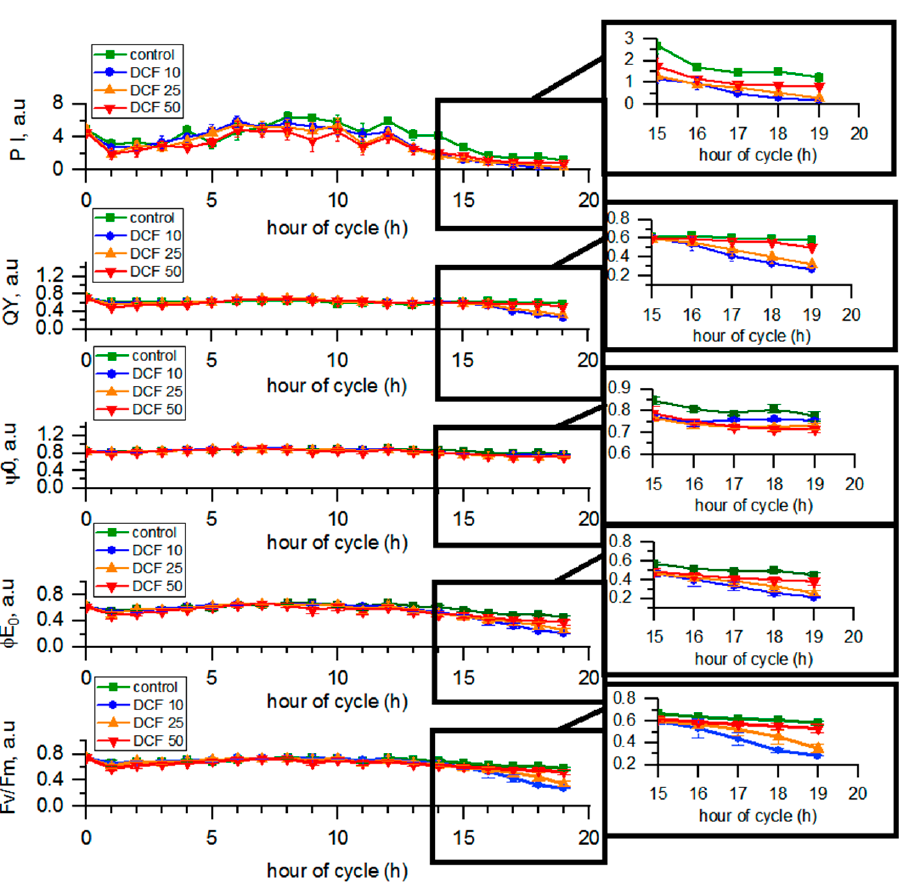
Figure 3. The parameters of photosynthesis obtained from the OJIP method. Data are presented as means ± SE. All the photosynthetic parameters of DCF10 and DCF25 and ψ 0 of DCF50 were statistically significantly different from controls (correlation comparison, p < 0.05, n = 3).